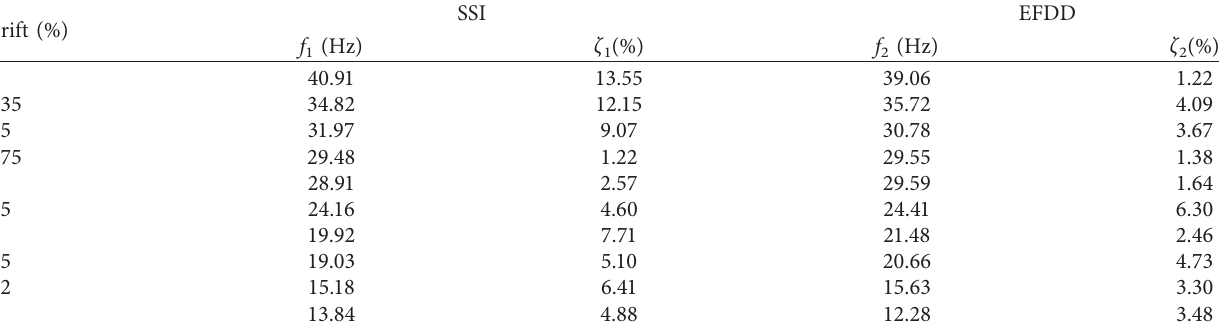
Figure 15: Variation of the (a) identified frequencies and (b) damping ratios with the progression of damage for different drift Table 3: Identified parameters for the first mode: SSI versus EFDD methods.